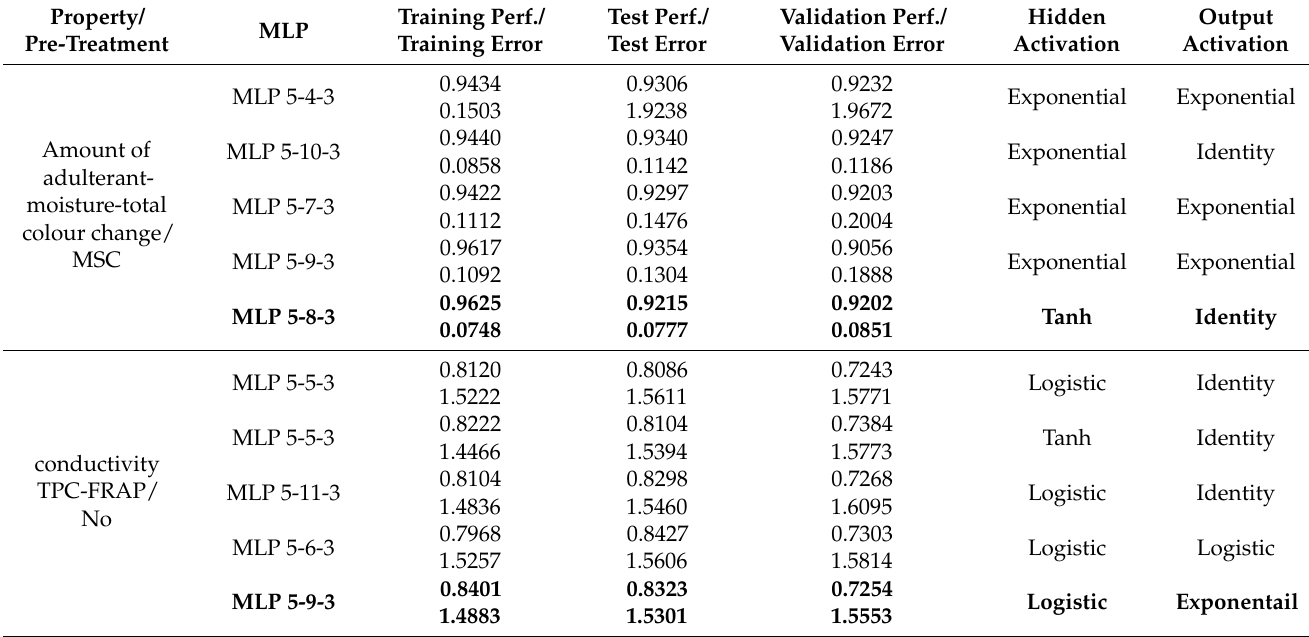
Table 2. Characteristics of ANNs selected for prediction of honey adulteration and physical and chemical properties of pure honey samples and prepared glucose syrup adulterations based on different NIR spectra pre-treatments (selected ANN models are marked